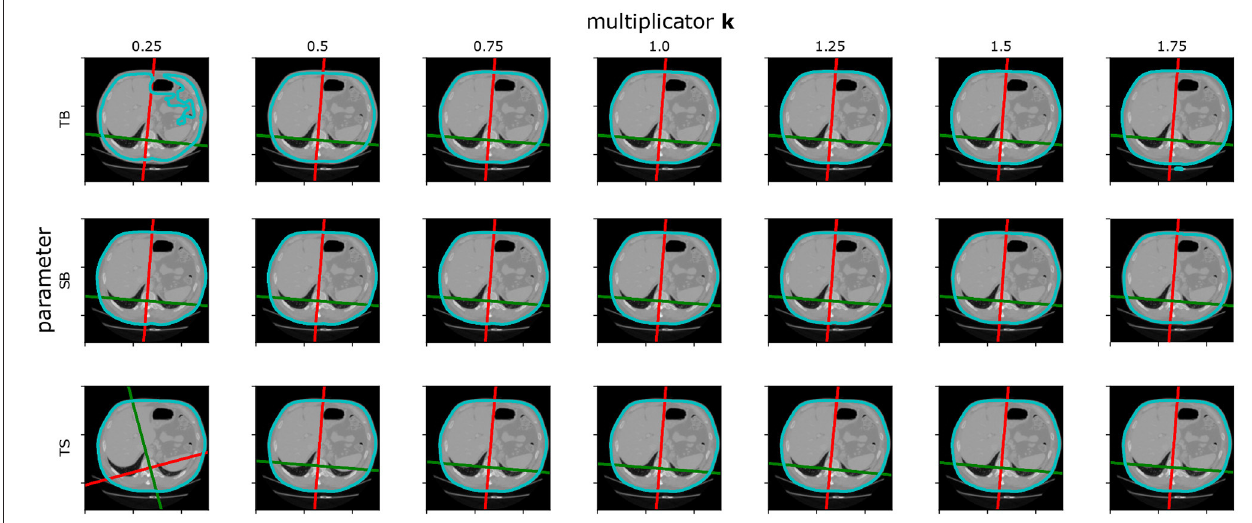
FIGURE 6 | Example of sensitivity of positional features to the algorithm parameters. k is the parameter value multiplicator. SB and TB are parameters sigma and threshold for Body extraction. TS is the threshold used in spine extraction. The surface segmentation error can be seen if the parameter TB is set to 0.25 of its default value. The sagittal and coronal plane position is lost if the parameter TS is set to 0.25 of its default